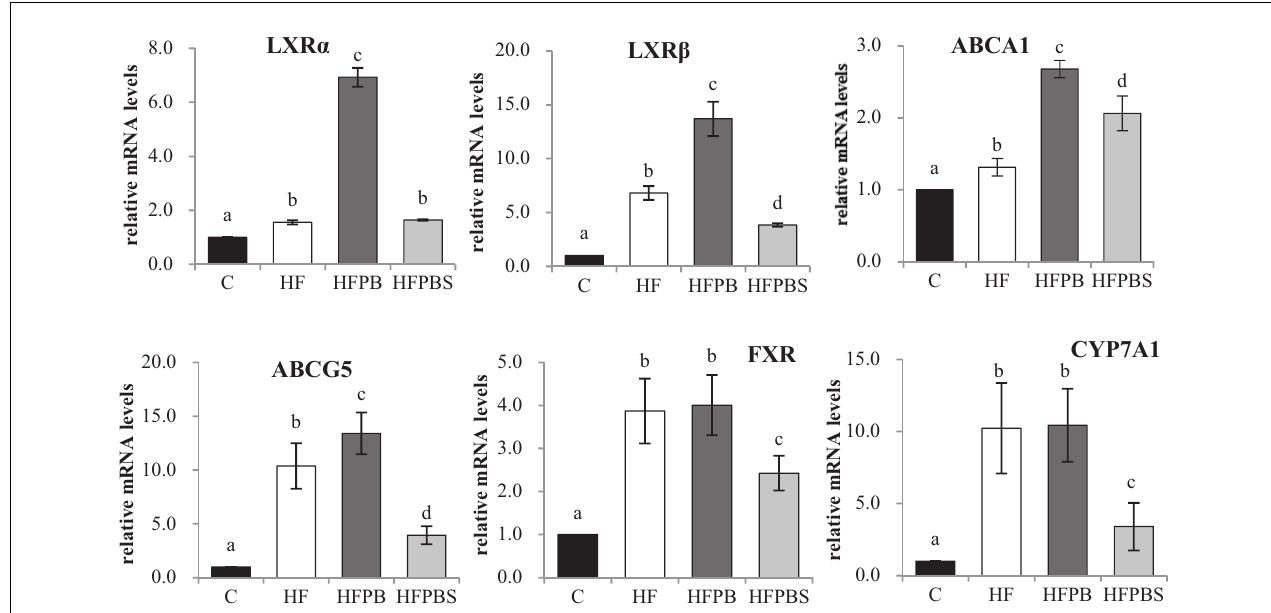
FIGURE 3 | Effects of diet on the transcription of genes related to lipid metabolism in the small intestine. The total RNA was extracted from freshly isolated small intestines, reverse transcribed to cDNA, and analyzed to detect the transcription of genes using RT-PCR. Gene transcription is reported as the mean ± SD ( n = 6) of the fold change relative to the C group. Error bars with different letters indicate significant differences ( P <